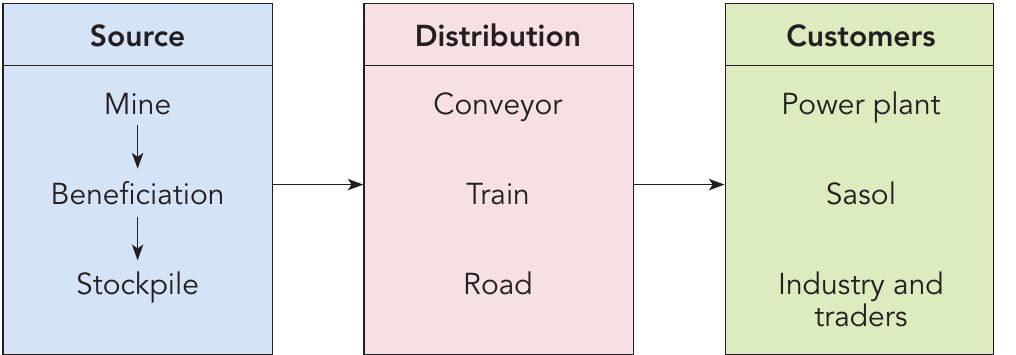
Figure 1: South African coal supply chain (Domestic) Source: Own model